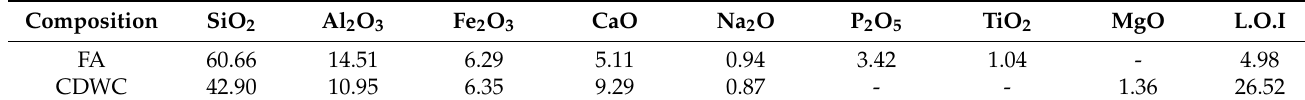
Table 2. Chemical composition of FA and CDWC.